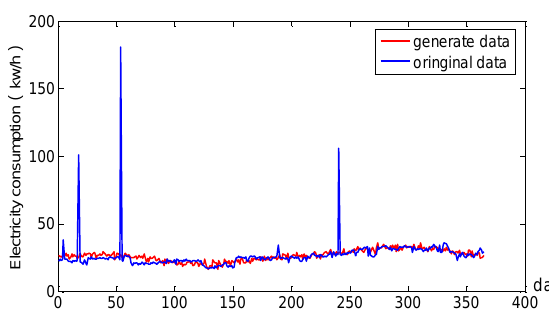
Figure 5. Comparison of CWGAN processing data set fit.